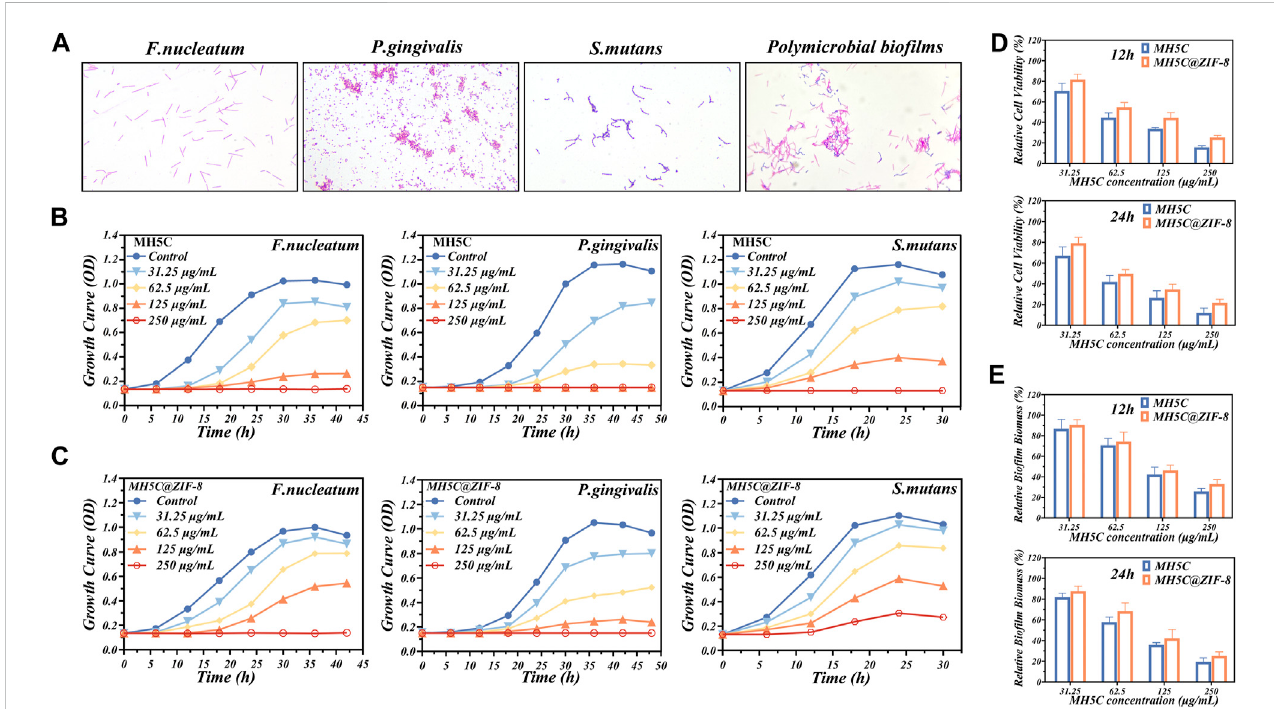
FIGURE 3 Antibacterial properties of MH5C@ZIF-8 NPs. (A) Gram staining of F. nucleatum , P. gingivalis , S. mutans , and polymicrobial bio fi lm. (B) Growth curves of thethreespeciesofbacteriainfreeMH5Cwithdifferentconcentrations. (C) GrowthcurvesofthethreespeciesofbacteriainMH5C@ZIF-8NPswithdifferent concentrations. (D) BacterialactivityinthepresenceoffreeMH5CandMH5C@ZIF-8NPswithdifferentconcentrationsafter12 hand24 h. (E) Bio fi lmbiomass in the presence of free MH5C and MH5C@ZIF-8 NPs with different concentrations after 12 h and 24